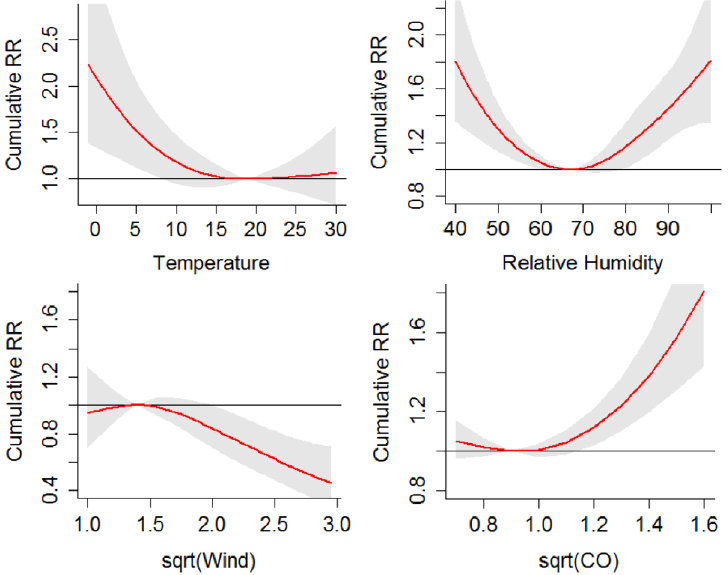
Figure 2. Plots of cumulative RR for COPD hospitalizations of the overall population (Jan/2015–Dec/2017, Chengdu, China) against: temperature, relative humidity, sqrt (wind speed) and sqrt